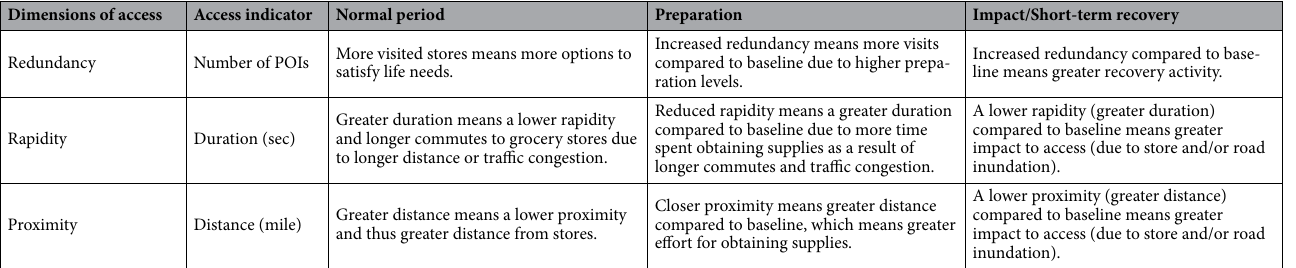
Table 2. Interpretation of access indicators during different disaster